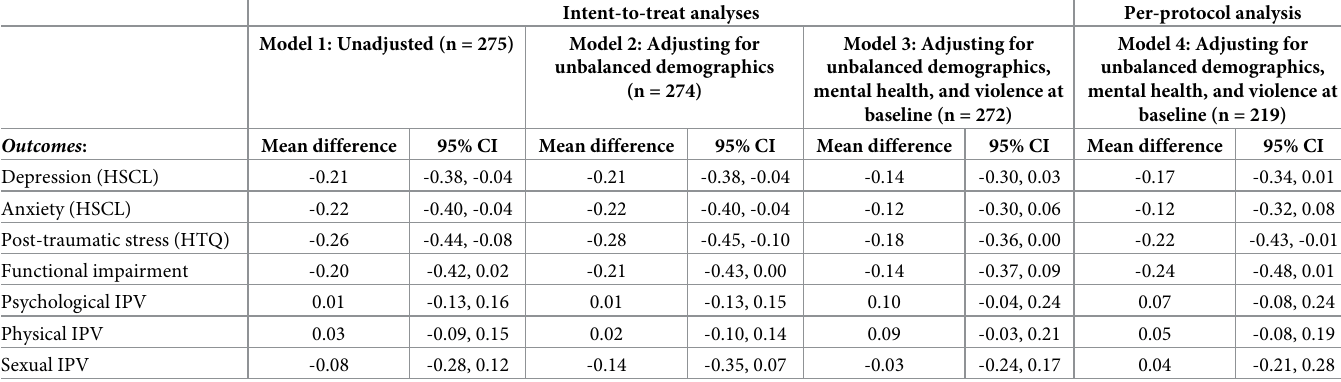
Table 4. Mean difference in primary and secondary outcomes at post-intervention between Nguvu and usual care group in intent-to-treat and per-protocol analyses.